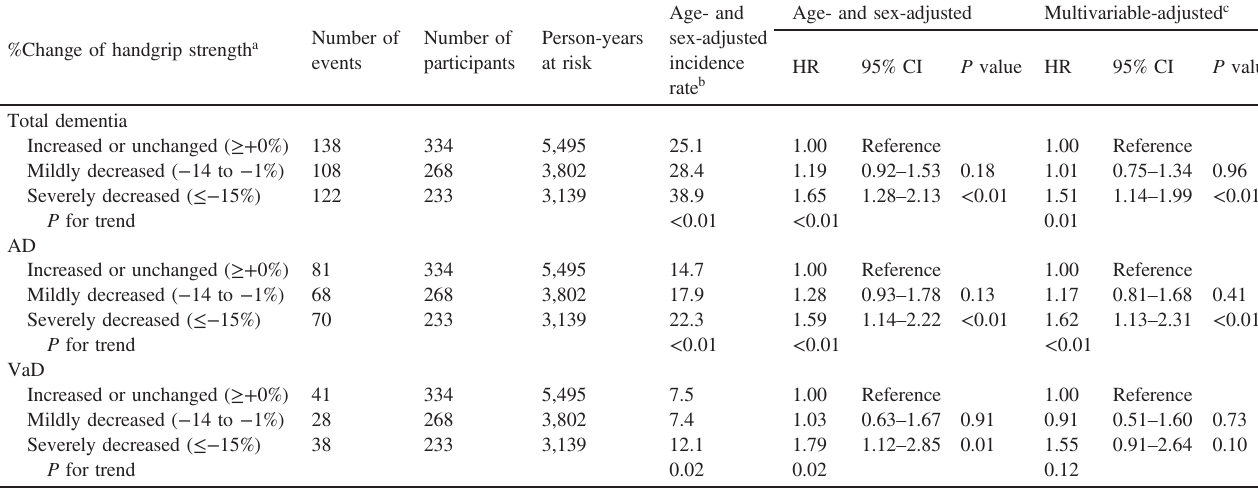
Table 5. Hazard ratios for the development of total dementia and its subtypes according to the %change of handgrip strength from midlife (1973 – 1974) to late life